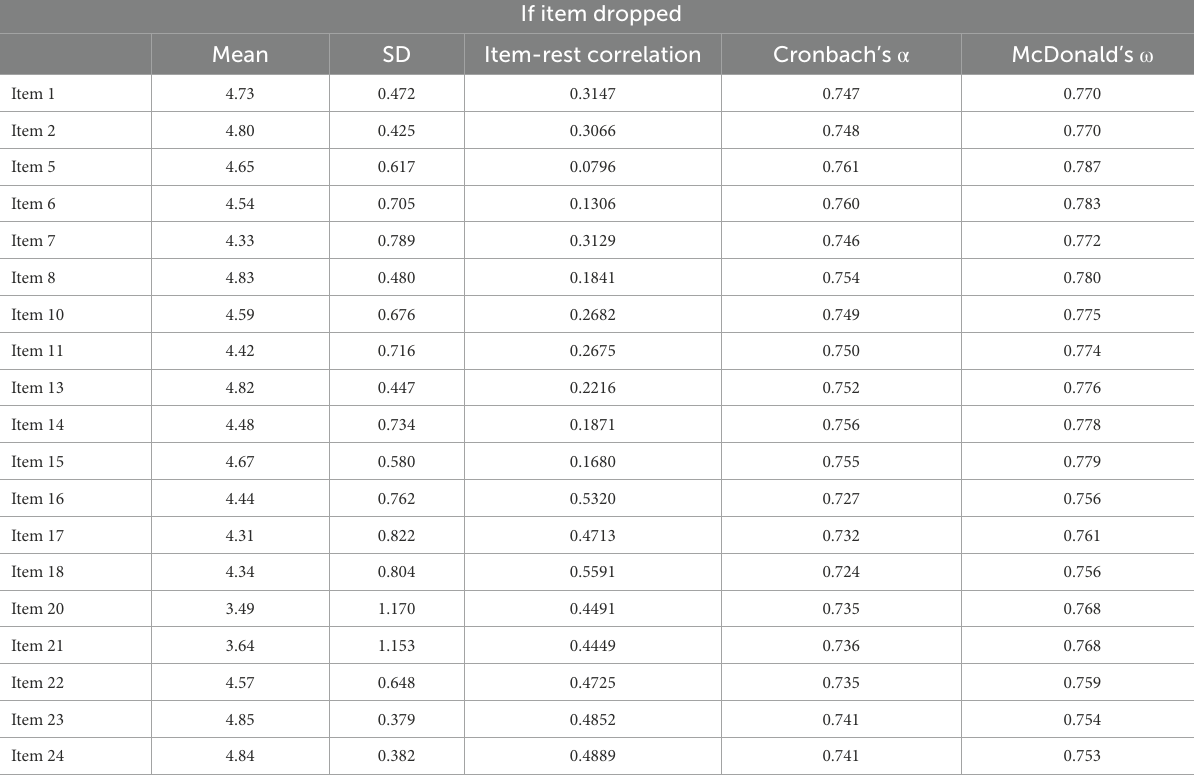
TABLE 3 Item reliability statistics for the final IQIB-ECEC 19-item